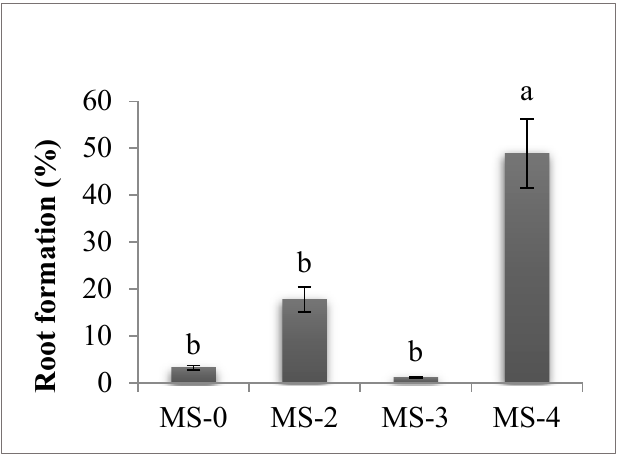
Figure 5. Culture medium influence in the sixth subculture on root formation. The values shown are means ± SE (n = 3). Differences among treatments indicated by different letters are significant according to Duncan’s MRT test ( p < 0.05).